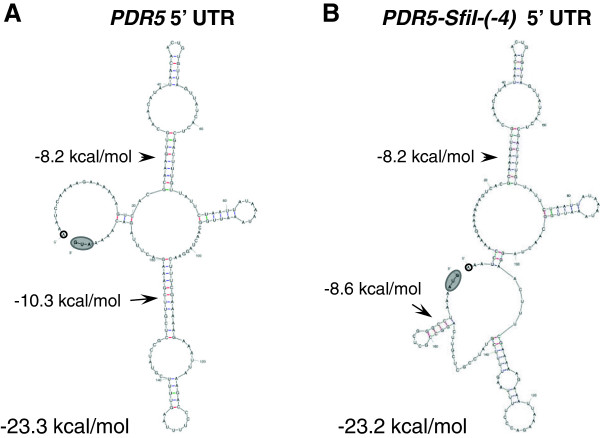
mRNA secondary structures predicted for the 5′ UTRs of wild-type PDR5 and PDR5 containing the originally created Sfi I stem-loop at −4 (construct #1). The most representative mRNA secondary structures predicted for the entire 5′ UTRs of wild-type PDR5 (three transcription start sites were determined at −171, -174 and −175 [35]) and wild-type PDR5 that has been modified to contain the SfiI site at −4 (construct #1) are shown in A and B, respectively. Arrows with numbers (kcal/mol) indicate secondary structures of significant stability. 5′ ends are highlighted with black circles and the AUG start-codons are highlighted as grey ovals. The calculated thermodynamic stabilities for the entire 5′ UTR of each predicted secondary structure is shown at the bottom of each structure.